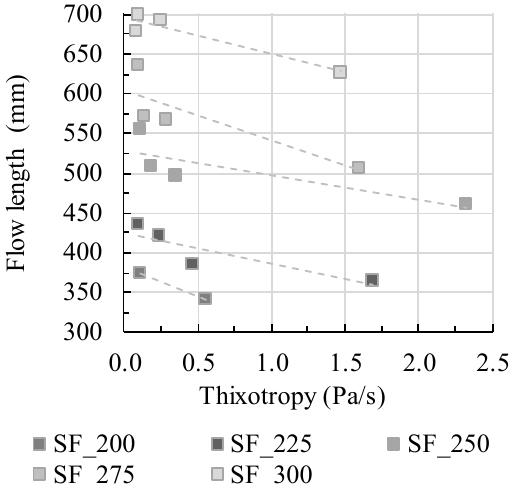
Figure 8. Effect of thixotropy value A thix on the flow distance depending on yield stress adjustment. The testing series 0.45_p and 0.45_m contain a w/c ratio of 0.4, wherefore thixotropic structural